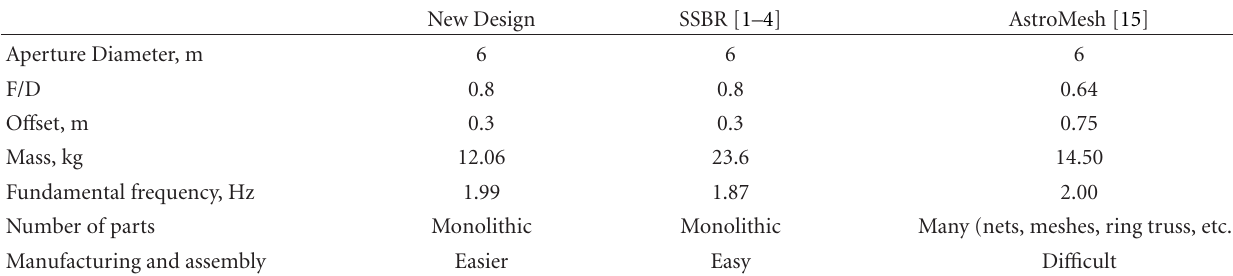
Table 5: Comparison of new design, SSBR, and